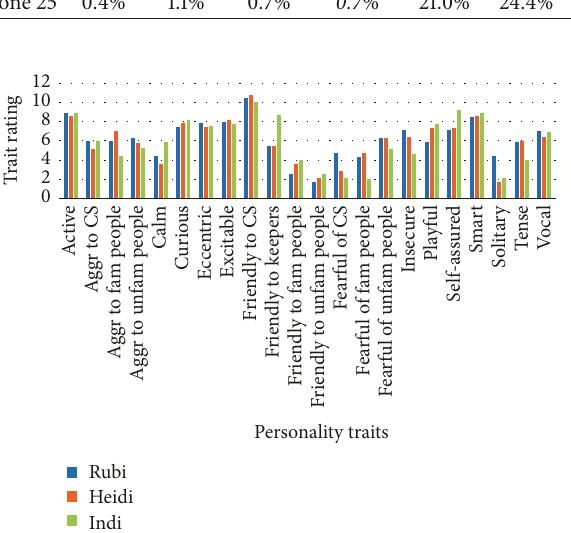
Figure 9: Personality profiles for each female compiled from ques- tionnairescompletedbykeepers.Aggr=Aggressive,Fam=Familiar, Unfam = Unfamiliar, and CS = Conspecific.